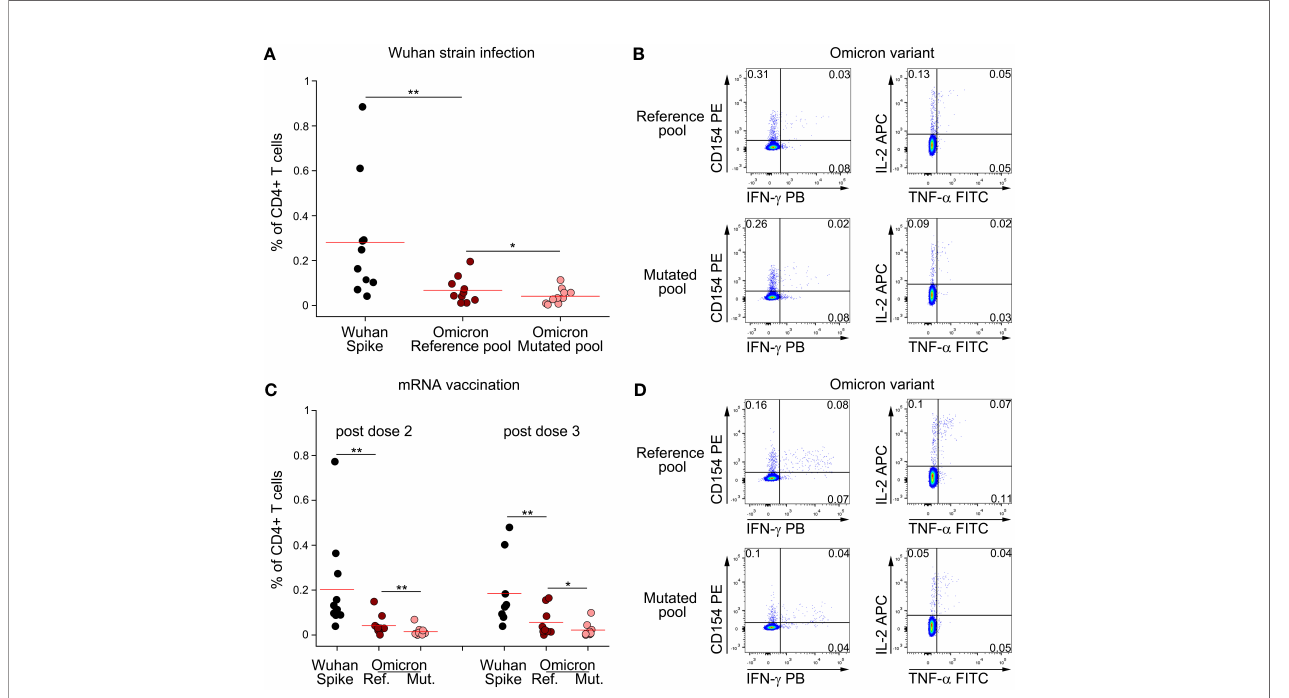
FIGURE 3 | Omicron variant does not signi fi cantly impair CD4+ T cell memory response to Spike following natural infection and mRNA vaccination. (A) Frequency of CD4+ T cells speci fi c for Wuhan Spike, Omicron variant reference or mutated pool in 10 subjects with previous Wuhan strain SARS-CoV-2 infection. Representative FACS plot are depicted in (B) . (C) Frequency of CD4+ T cells speci fi c for Wuhan Spike, Omicron variant reference or mutated pool in mRNA-vaccinated subjects enrolled after dose 2 (n=11) or dose 3 (n=9) administration. Representative FACS plot are depicted in (D) . Data in (A, C) are subtracted of background, unstimulated condition. Red lines in (A, C) represent mean value. *p < 0.05; **p < 0.01, calculated Wilcoxon-Signed Rank